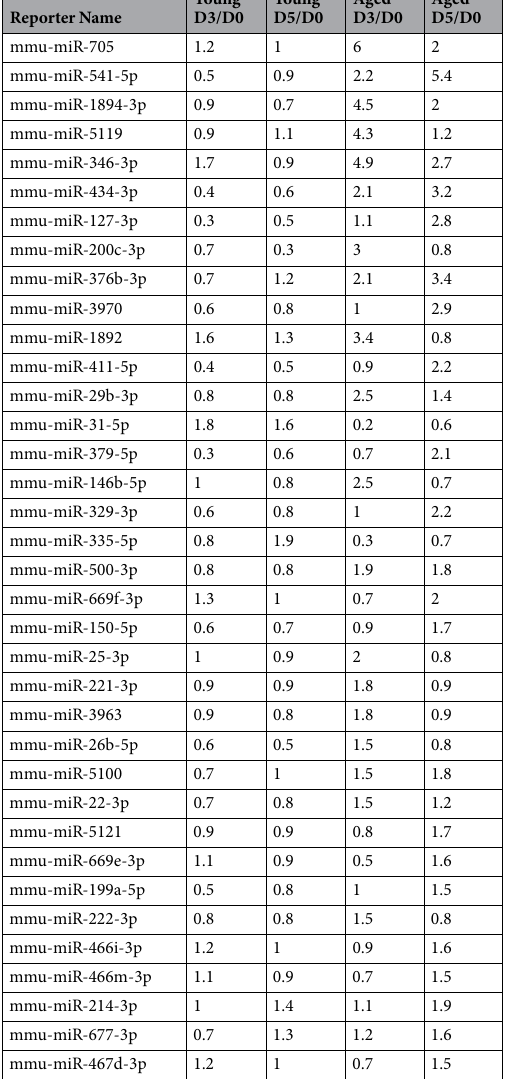
Table 1. Subset of differentially expressed miRNAs in young versus aged skin during wound healing (microarray